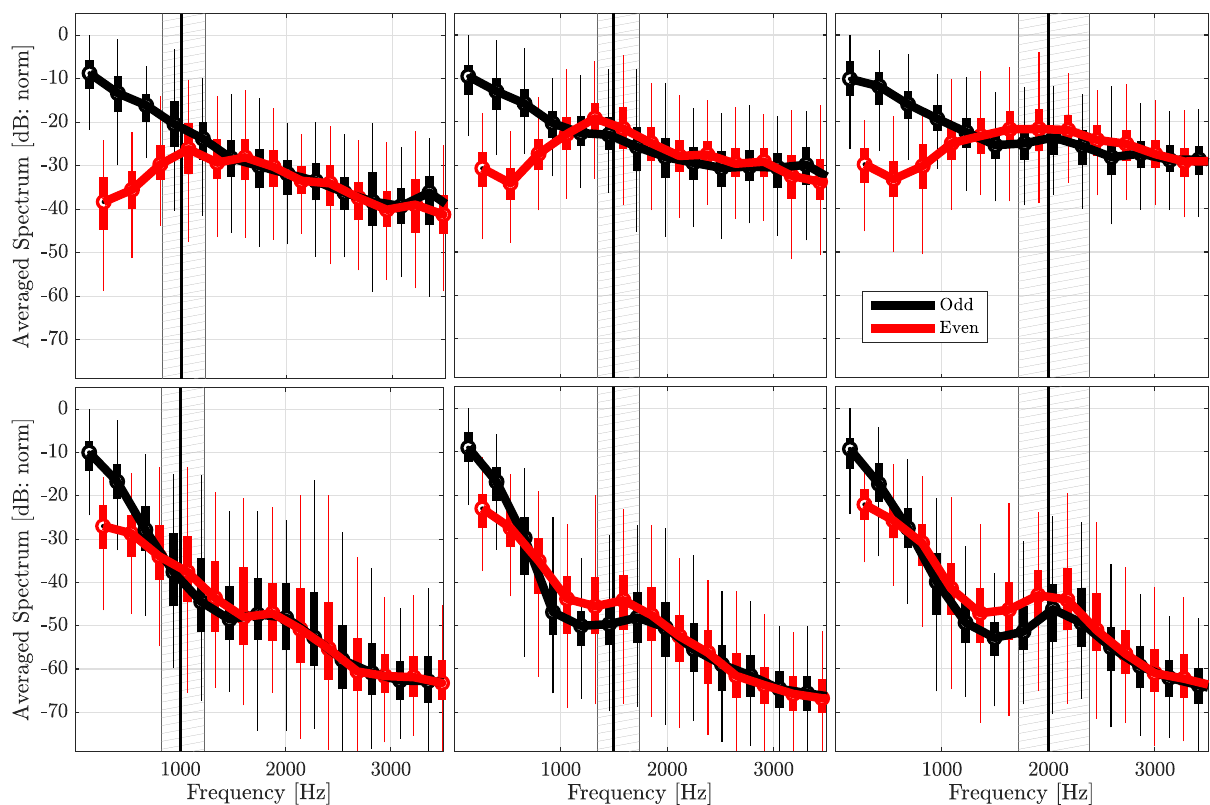
Figure 4. Measured external spectra, averaged over six notes played on each of three resonators with different cutoff frequencies. Top panels depict forte dynamics and bottom panels depict piano dynamics. Each box plot is computed from the n th rank harmonic to present an averaged spectra that is characteristic to the resonator across different fi ngerings with fundamentals ranging from 114 Hz to 154 Hz, and is positioned at the average frequency of the respective n th rank harmonic. Data from manually waved microphone (Neumann U87 4 m distance). Black: odd harmonics, red: even harmonics, vertical line: cutoff frequency of the resonator. Box plots within hatched area have atleast one harmonic near cutoff. Solid black and red lines trace the median of each box plot. The median amplitude of the fundamentals are normalized to 0 dB in each panel. Boxes span from 25 th to 75 th percentiles and thin lines show the span of the data ignoring